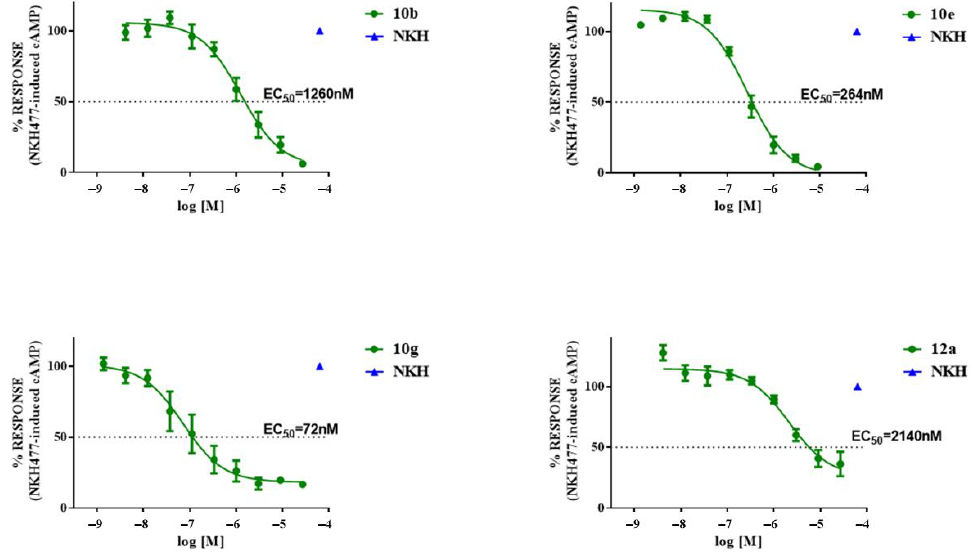
Figure 7. Concentration-response curves of compounds in the cAMP Hunter assay. Curves show the effect of increasing concentrations of compounds on NKH-477-induced cAMP levels in stable CHO cells expressing the human CB2. Data are reported as the means ± SEM of three independent experiments conducted in triplicate, normalized to the maximal and minimal responses.